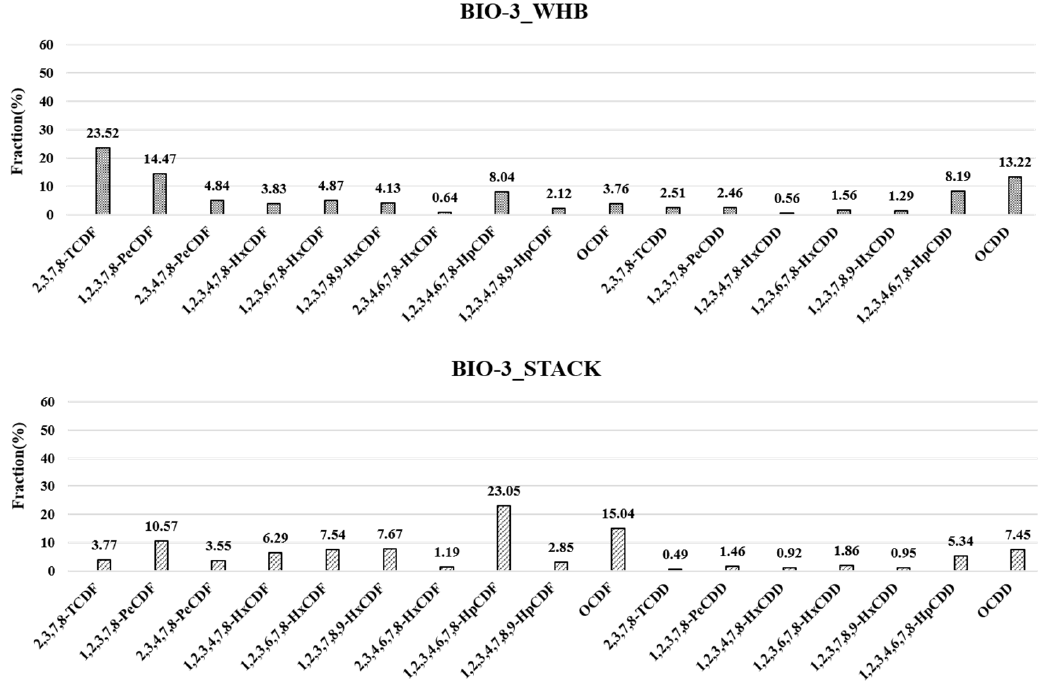
Figure 5. PCDD/DFs congener pattern in Bio-3 incineration plant.